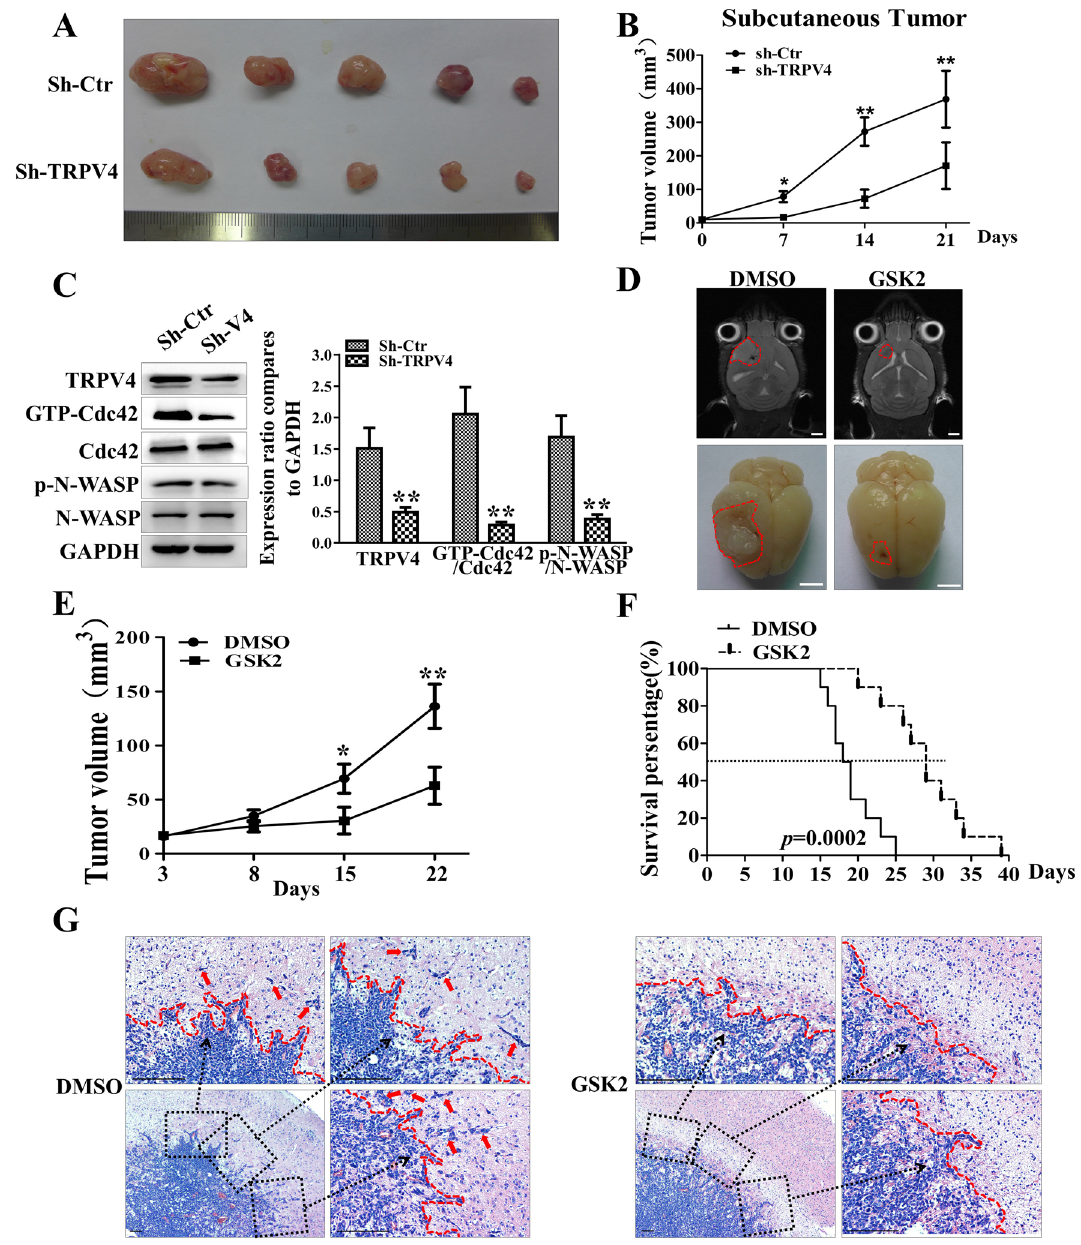
Figure 7. Blocking TRPV4 impairs the invasion-growth of glioblastoma in vivo. ( A ) The gross observation of a subcutaneous tumor at 21 days postinjection after dissection from the groin (upper: sh-Ctr; lower: sh-TRPV4). ( B ) The volume of subcutaneous tumor was calculated weekly after implantation. ( C ) Western blot showing the expression of TRPV4 and the activation of the Cdc42/N-wasp axis in subcutaneous glioblastoma tissues. ( D ) Representative MRI images (scale bar = 5 mm) and gross observations (scale bar = 5 mm) of orthotopic xenograft glioblastoma from the DMSO and GSK2 groups. ( E ) The tumor value of intracranially transplanted glioblastoma with micro-MRI detection at 3, 8, 15, and 22 days after treatment. ( F ) The survival duration of the mice was monitored in the indicated groups, and the survival time was analyzed by the Kaplan–Meier method and compared by the log-rank test. ( G ) H&E staining of orthotopic glioblastoma xenografts to explore the invasion states of glioblastoma in the DMSO and GSK2 groups., scale bar = 100 μm. * p < 0.05, ** p <